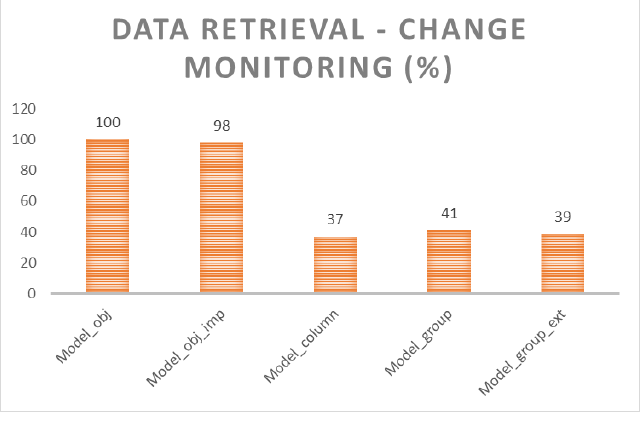
Figure 19. Data retrieval (change